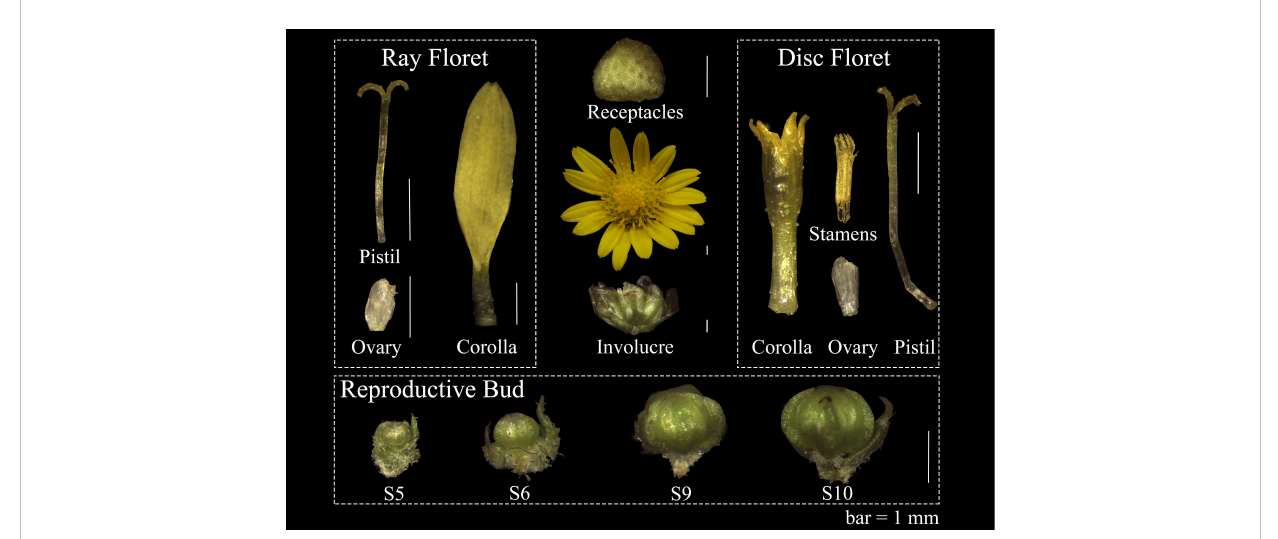
FIGURE 1 Floral organs on capitulum and four development stages reproductive bud in C. lavandulifolium for qRT-PCR.